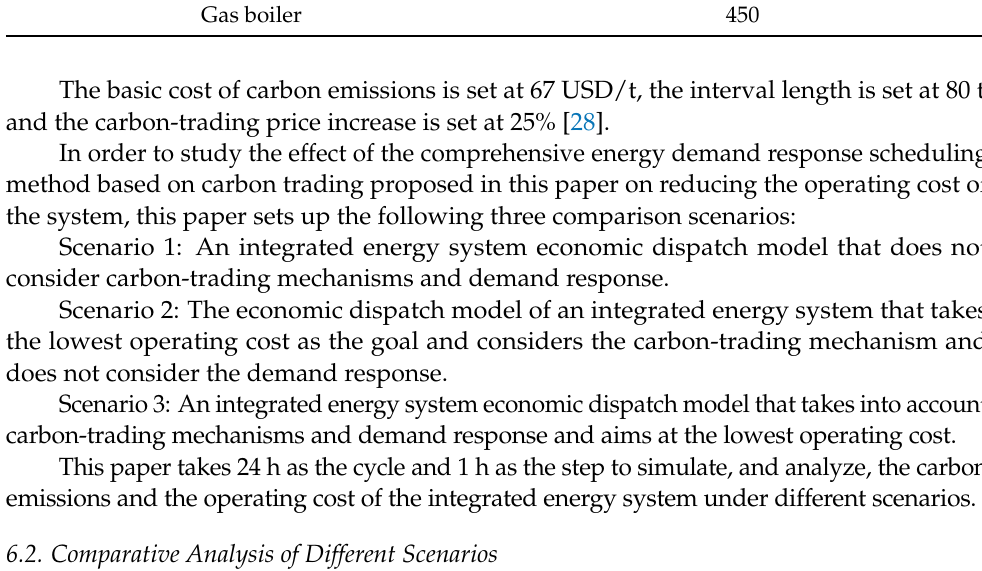
Table 3. Optimal solutions in different